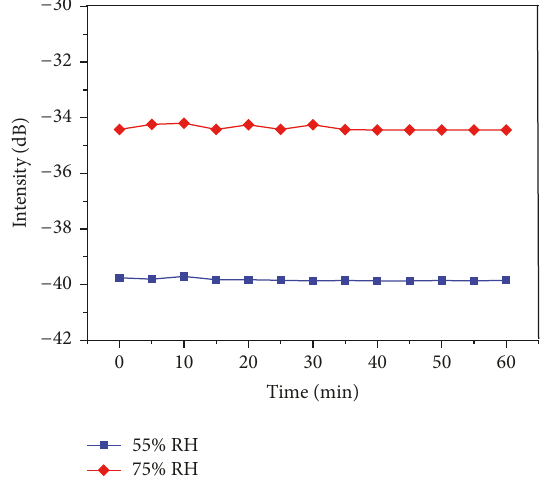
Figure 8: Stability testing